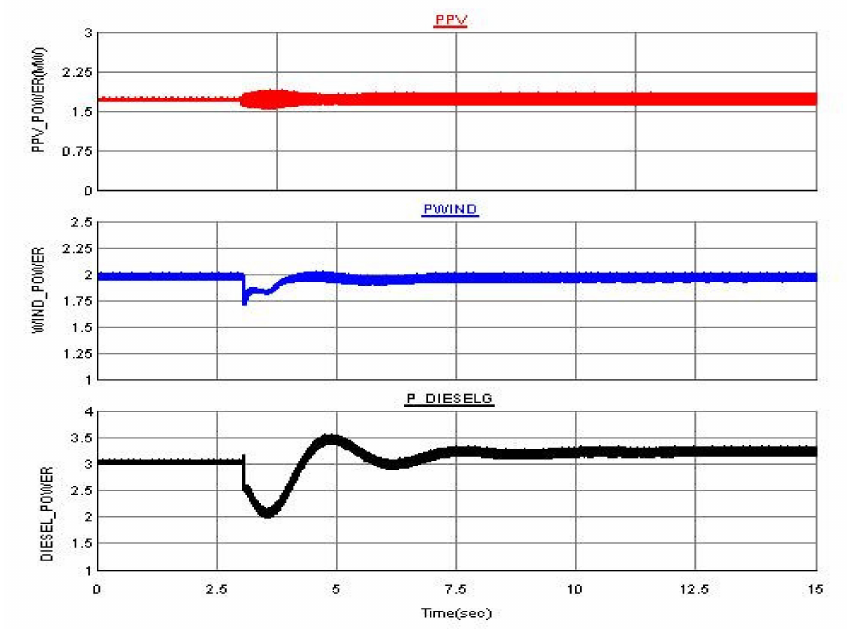
Figure 11. Photovoltaic (PV), wind and diesel generator generated powers.